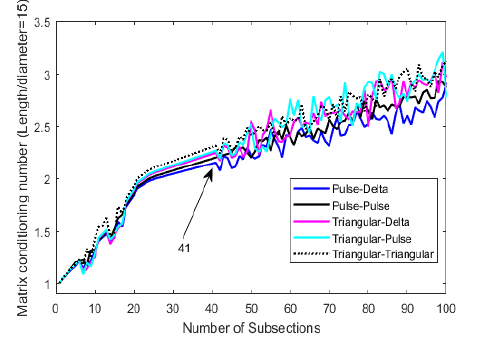
Figure 9. K ( L ) vs. N with different B/T